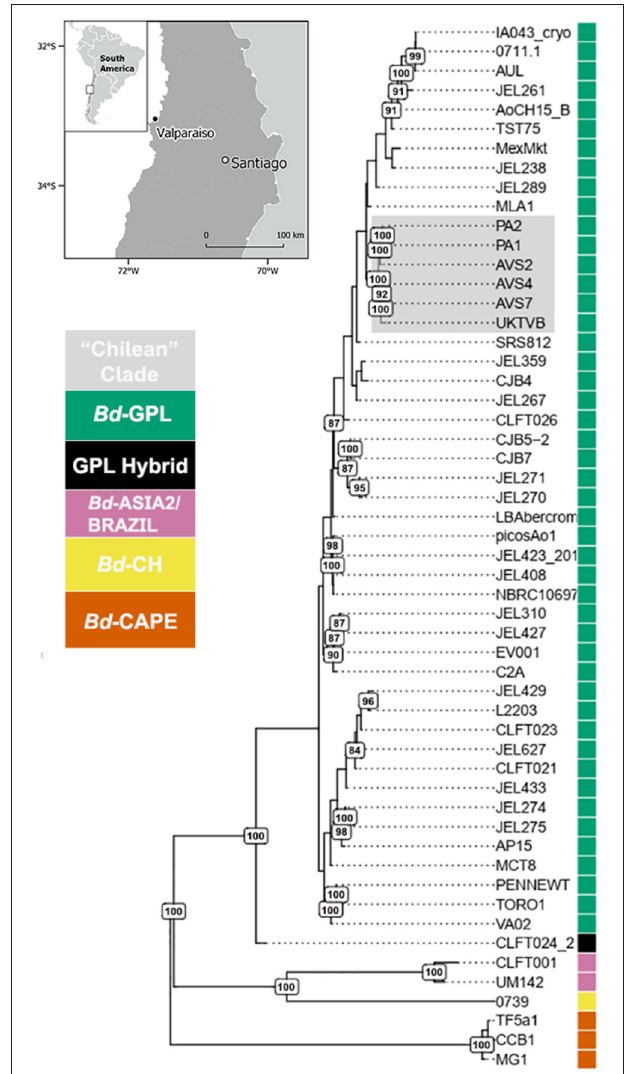
FIGURE 2 | Global phylogeny of 54 isolates of Batrachochytrium dendrobatidis (Bd) based on 363,497 segregating sites obtained by whole genome sequencing. The clade containing the Bd isolates PA1 and PA2 from captive C. gayi grouping with other Bd isolates from Chile and the United Kingdom is highlighted in gray. The branches of the tree are weighted (thickness) by bootstrap support (500 replicates), with branches with 80% of support and above